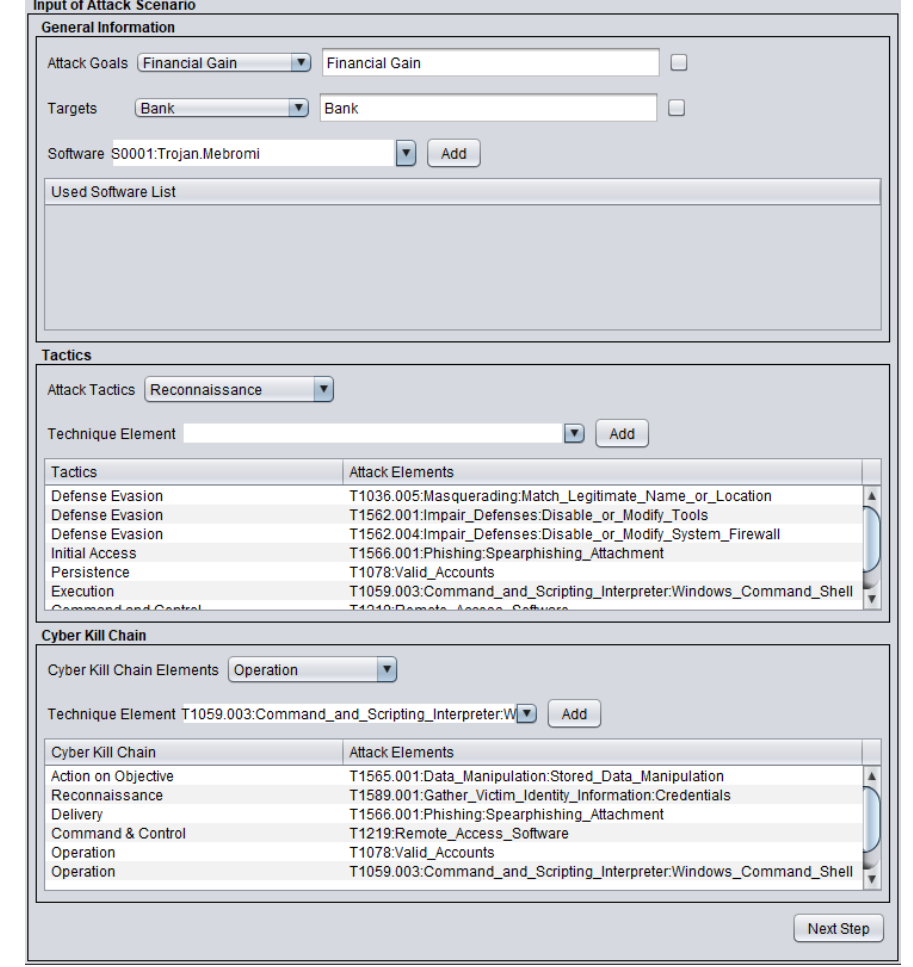
Figure 9. Attack scenario input screen.